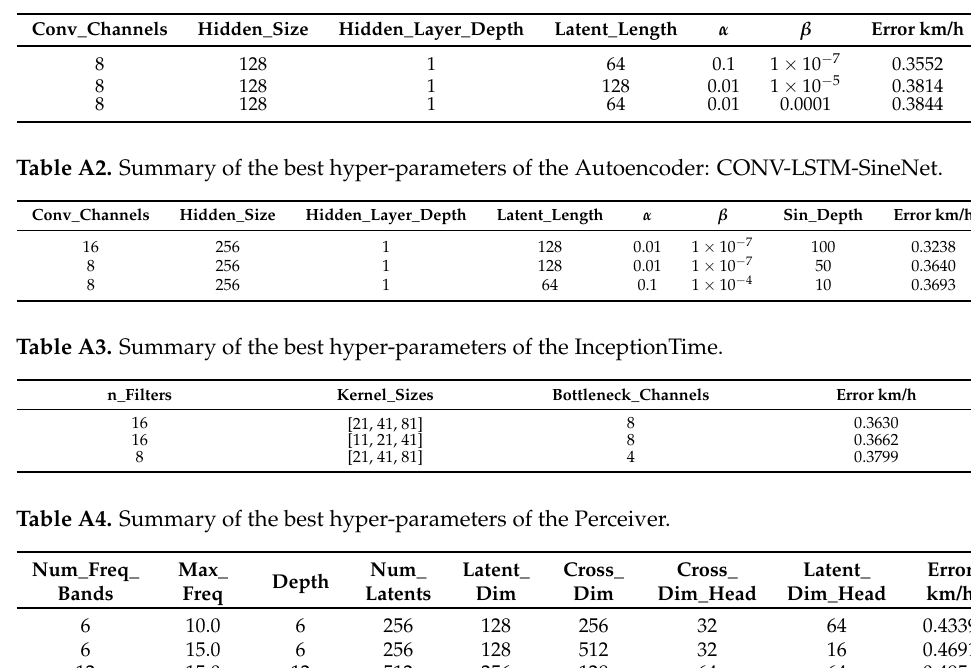
Table A1. Summary of the best hyper-parameters of the Autoencoder: CONV-LSTM-CONV.